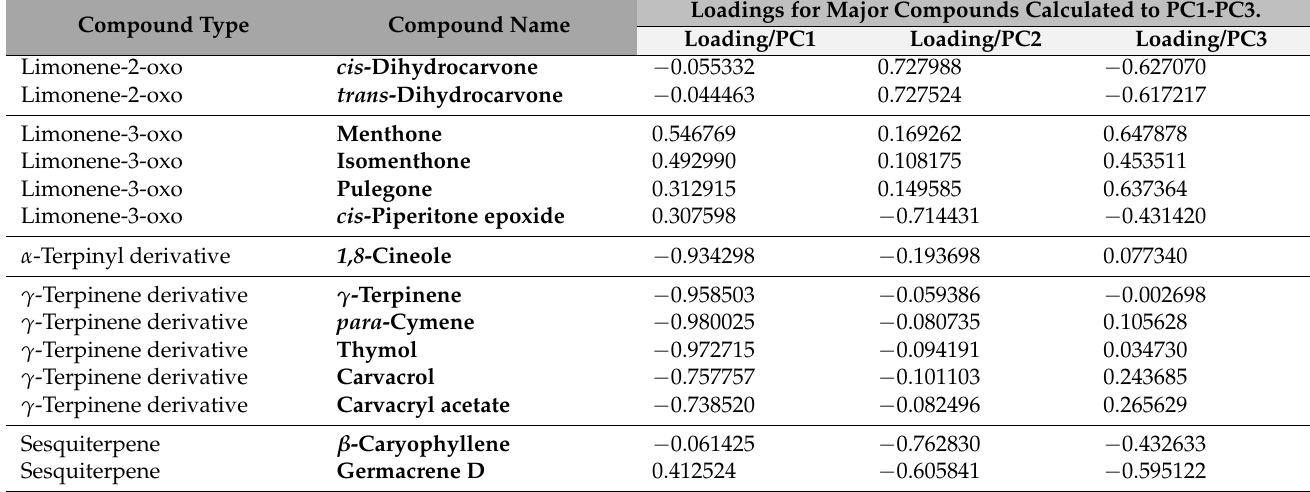
Figure 3. Scatterplot of PC1 vs. PC3. Table 3. Loadings of the 14 major constituents of the investigated EO samples in the principal components PC1-PC3. Loadings for Major Compounds Calculated to PC1-PC3. Compound